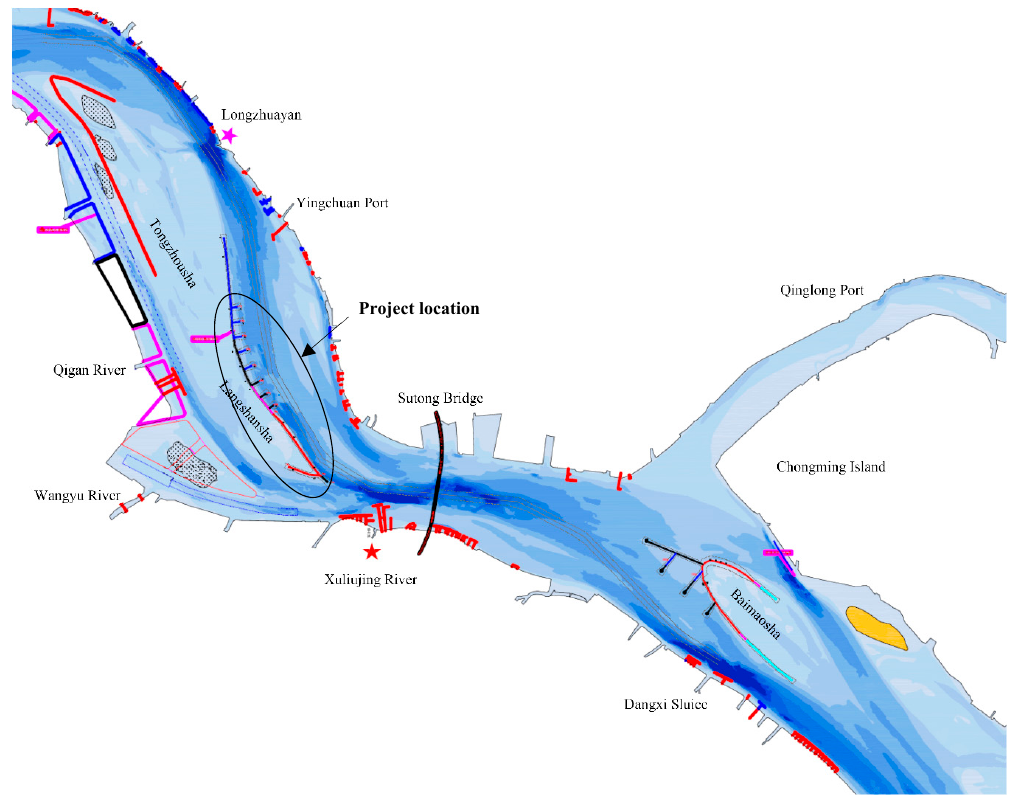
Figure 4. A location map of the channel training project in the estuary of the Yangtze River.